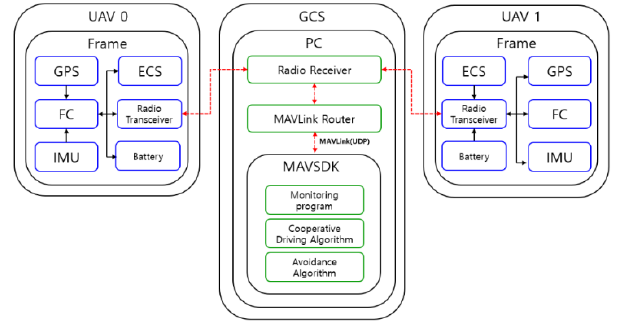
Figure 2. Structure of the unmanned aerial vehicle’s control system.